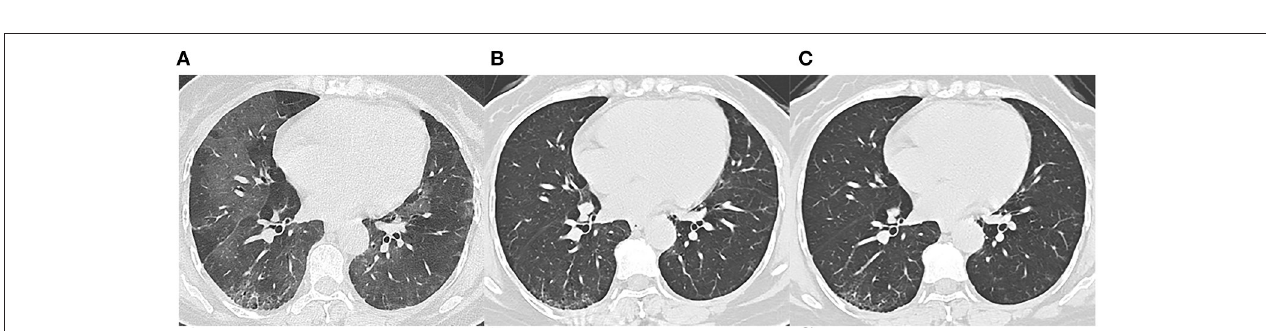
FIGURE 2 | Follow-up chest CT images of a 52-year-old male with COVID-19. (A) At discharge, CT imaging shows parenchymal bands, irregular interfaces, and traction bronchiectasis in left upper lobe and right lower lobe. The lesions are almost revolved on the 3-month follow-up (B) and 7-month follow-up (C) CT. This patient was enrolled in non-fibrosis group.